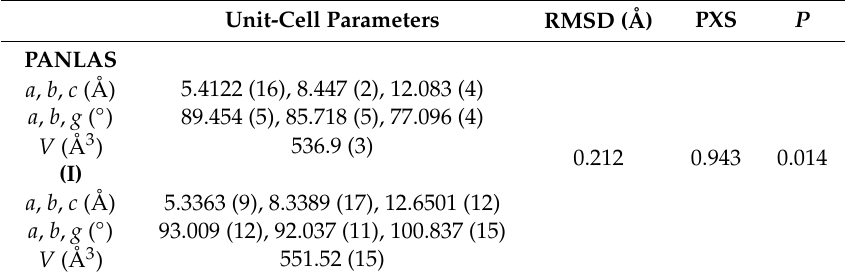
Table 2. Packing similarity in matched crystal structures of PANLAS and (I) co-crystals.